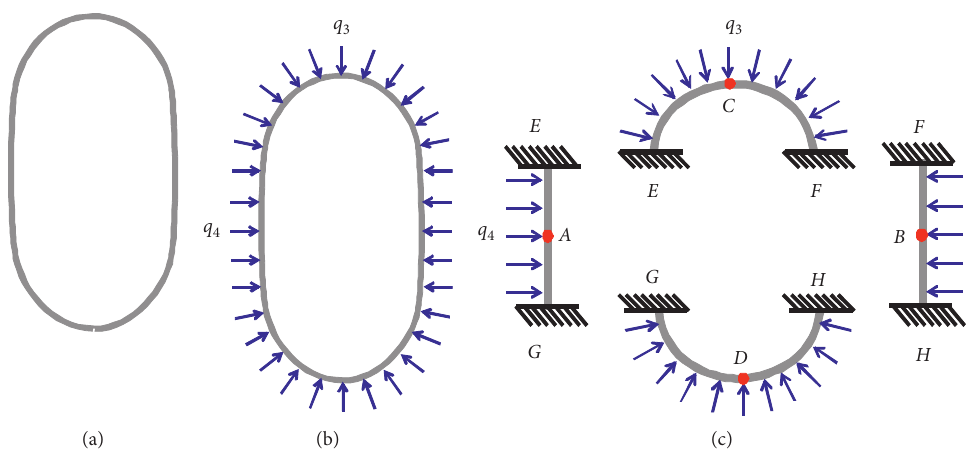
Figure 7: Instability mechanism analysis of the peripheral bearing